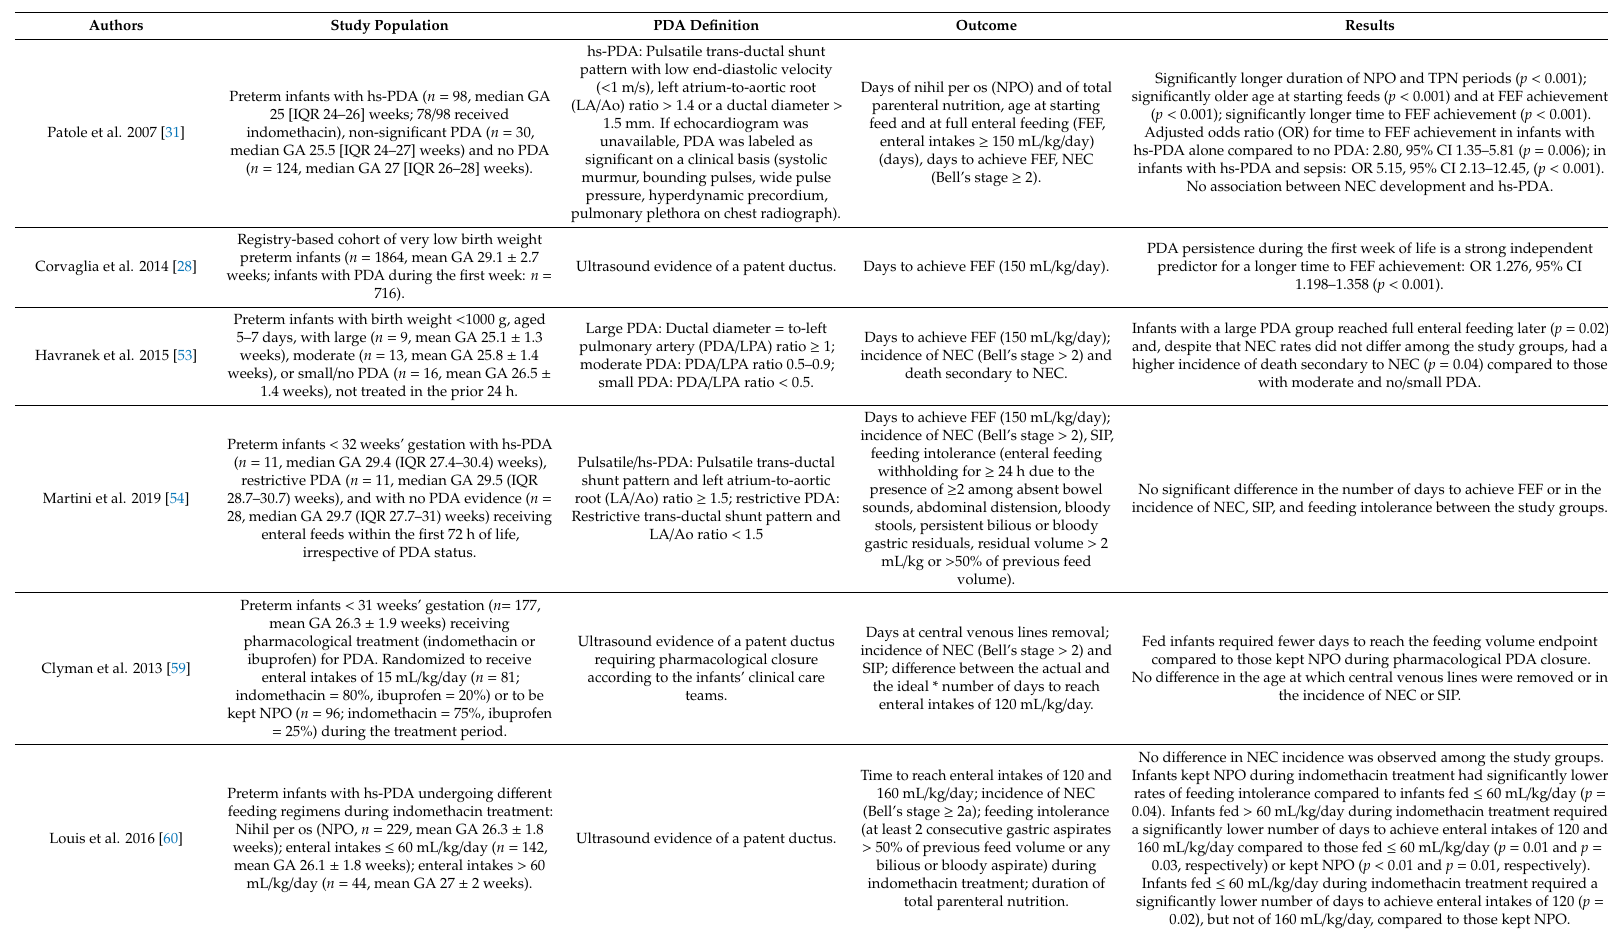
Table 2. Association between the presence of a patent ductus arteriosus (PDA) and gastrointestinal outcomes in preterm